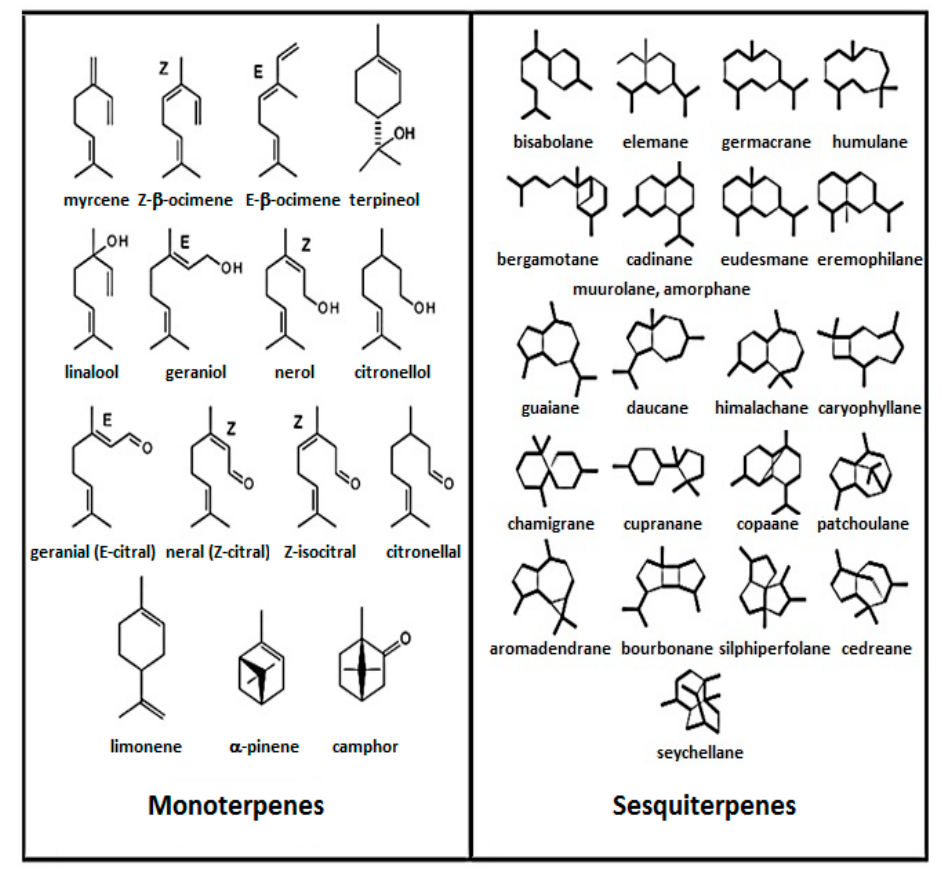
Figure 1. Structures of some terpenes.